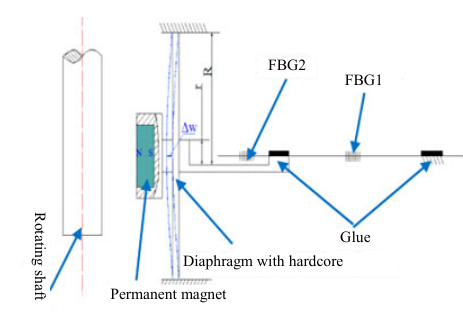
Fig. 17 Vibration sensor structure of FBG.